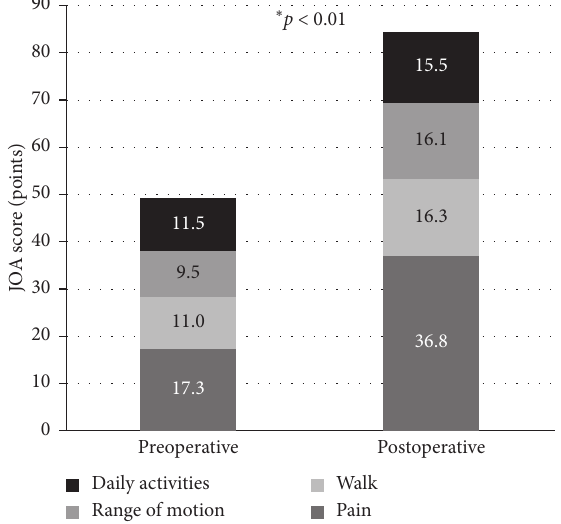
Figure 4: Preoperative and postoperative JOA scores. The JOA score is significantly improved from the preoperative mean of 49.3 to the postoperative mean of 84.7 ( p � 0 . 7336, Wilcoxon rank sum test).